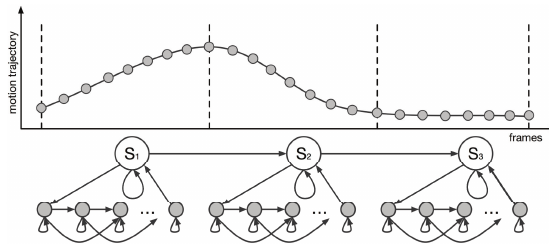
Figure 7. The model is built from a sample